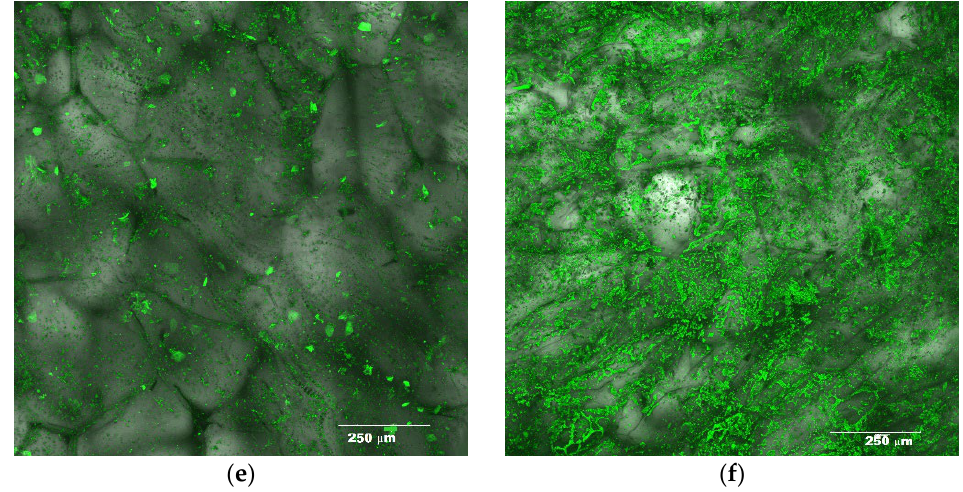
Figure 1. Structure of raw and fermented vegetables (confocal microscope): ( a ) unfermented beetroot; ( b ) fermented beetroot; ( c ) unfermented carrot; ( d ) fermented carrot; ( e ) unfermented red bell pepper; ( f ) fermented red bell pepper.